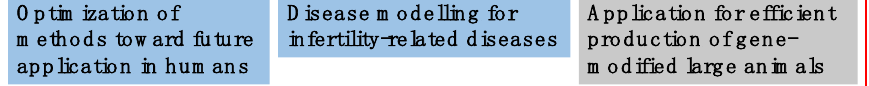
Figure 2. Significance of germ-cell study using large animal models. Cartoons of large animals (monkey, dog, and pig) were obtained from the graphical abstract of our previous study [40].